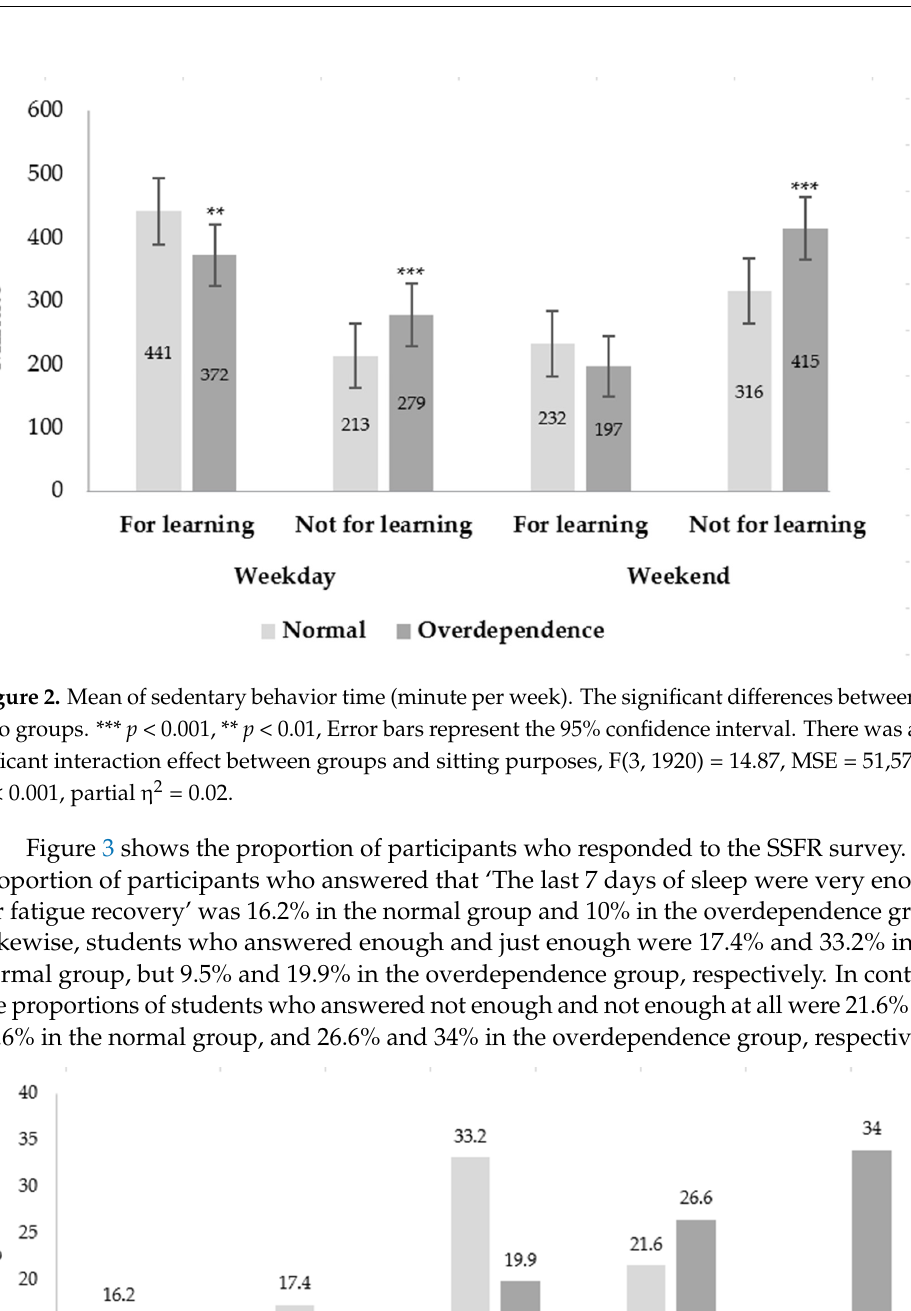
Figure 3. The proportion of participants who responded to the satisfaction with sleep fatigue recovery survey.